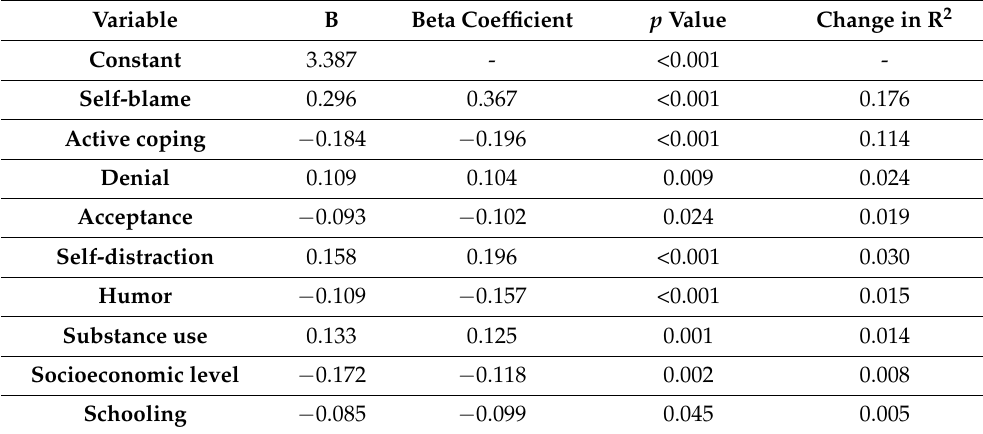
Table 6. Multiple regression analysis for stress in